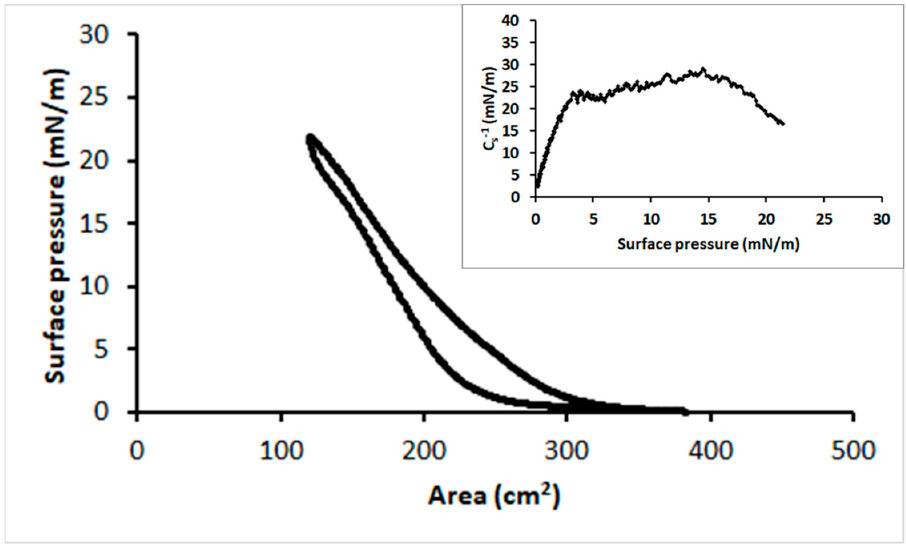
Figure 1. Surface pressure-area isotherm, with cycle, for lysozyme at a concentration of 0.1 g·L − 1 . Inset: Elastic modulus curve from the isotherm (only compression) of Figure 1.